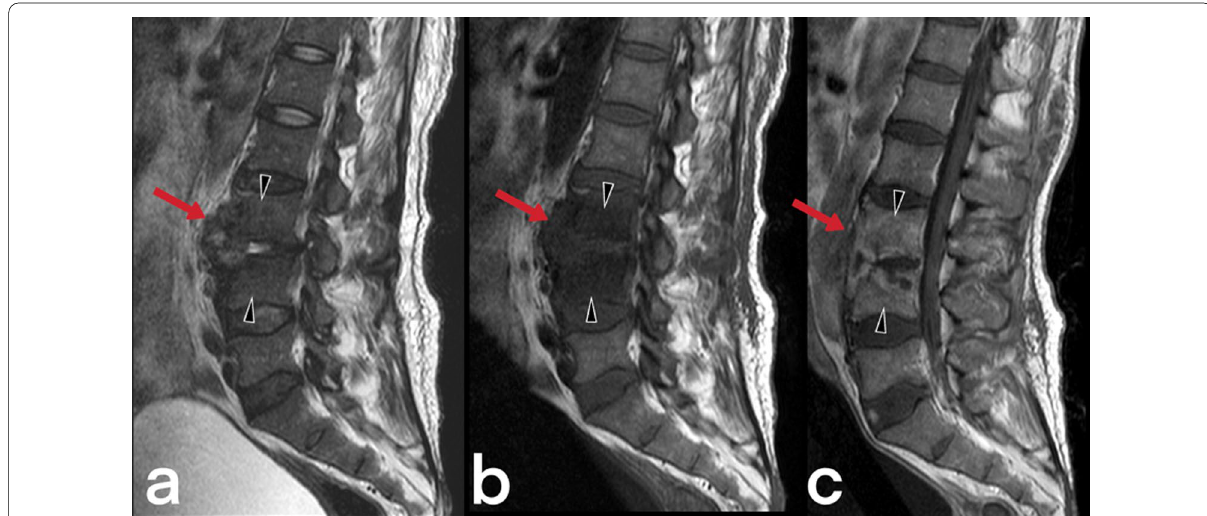
Fig. 45 MR images of lumbar vertebrae of a 47-year-old male with tuberculous spondylodiscitis. Sagittal T2-weighted image ( a ) shows the heterogeneous low signal in the anterior parts of the L3 and L4 vertebral bodies and L3-4 intervertebral disc, which offers minimal anterior subligamentous extension (arrows). Pre-contrast ( a ) and post-contrast ( b ) T1 weighted images reveal diffuse contrast enhancement of both vertebral bodies in keeping with spondylodiscitis